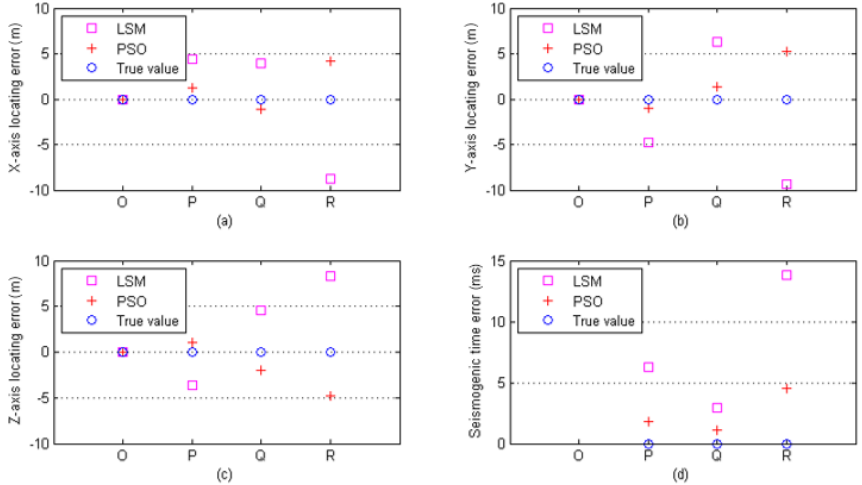
Figure 3. Comparisons of the errors in the source location parameters between the LSM and PSO algorithms. (a) Comparisons of the x -axis locating error. (b) Comparisons of the y -axis locating error. (c) Comparisons of the z -axis locating error. (d) Comparisons of the errors in the origin-time estimation.